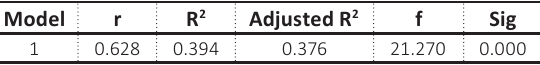
Table 4. Regressing intrapreneurship variable